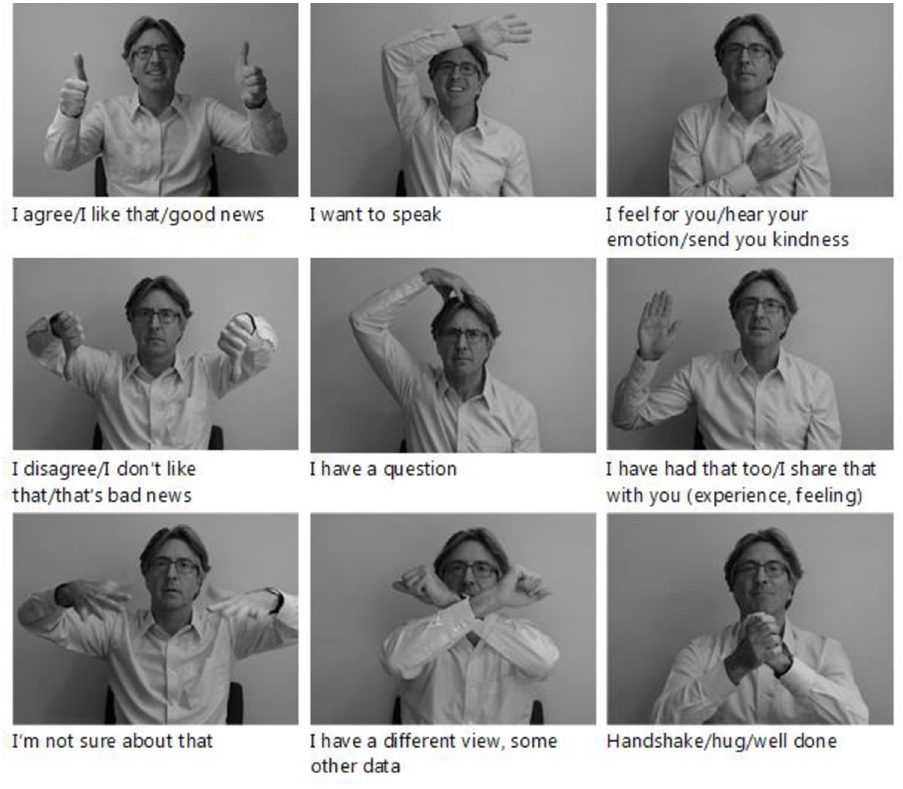
Fig 1. Video meeting signals taught during the training session of Experiment 1 (demonstrated by